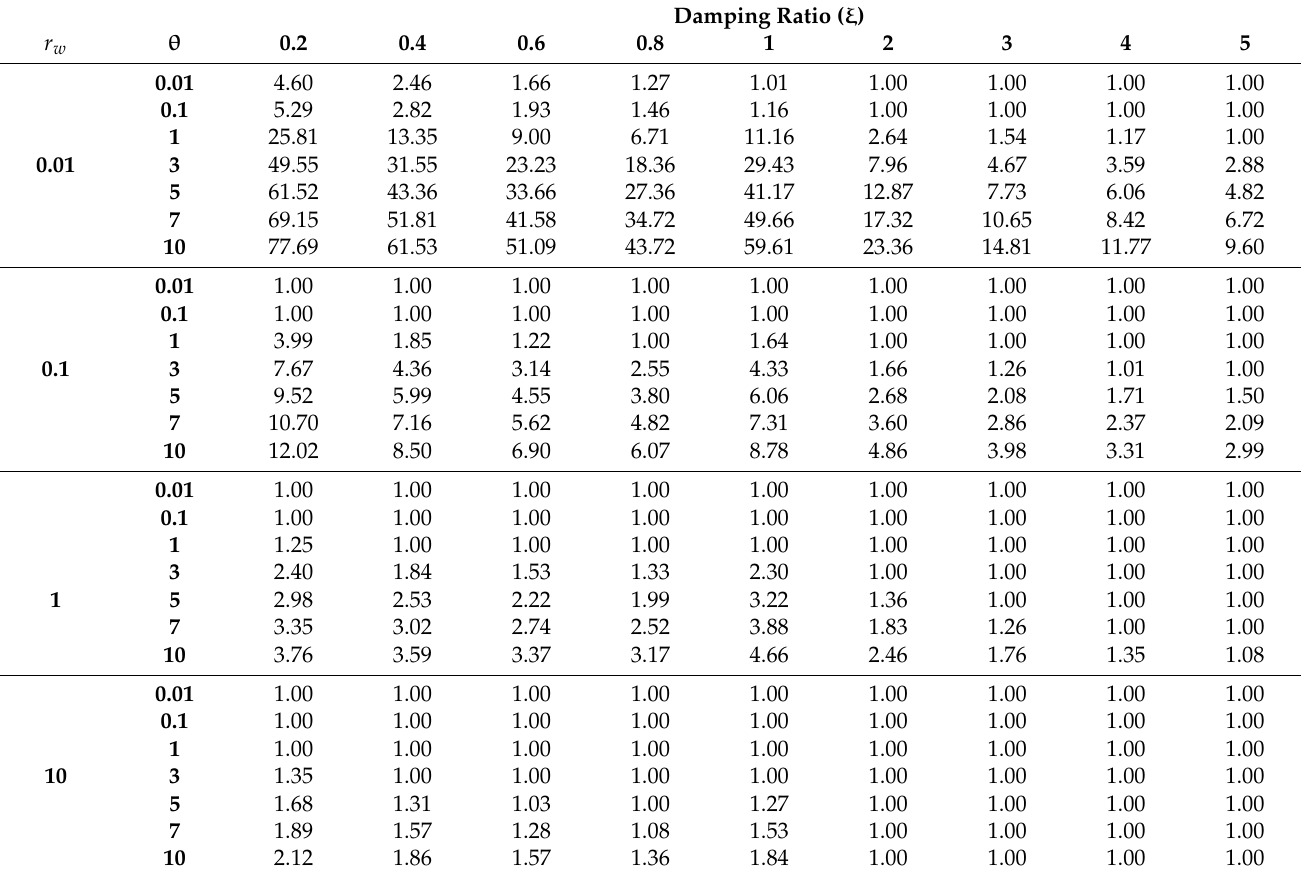
Table 6. Normalized TV for MPC (Process 2, setpoint response).